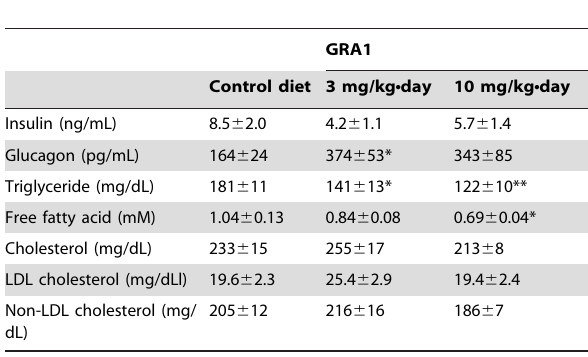
Table 2. Plasma measurements in DIO hGCGR mice treated for 10 weeks with GRA1 administered as a food